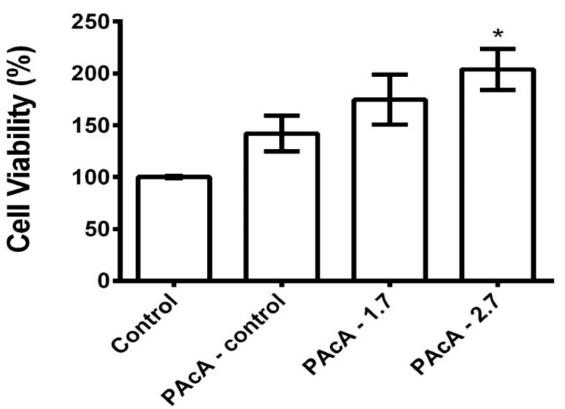
Figure 6. Cell viability of L929 cells on PAcA-control and hybrids (PAcA 1.7 and PAcA-2.7) film after 24 h in culture. p < 0.05, n = 4. The asterisk (*) indicates a significant difference between the control and treated groups.